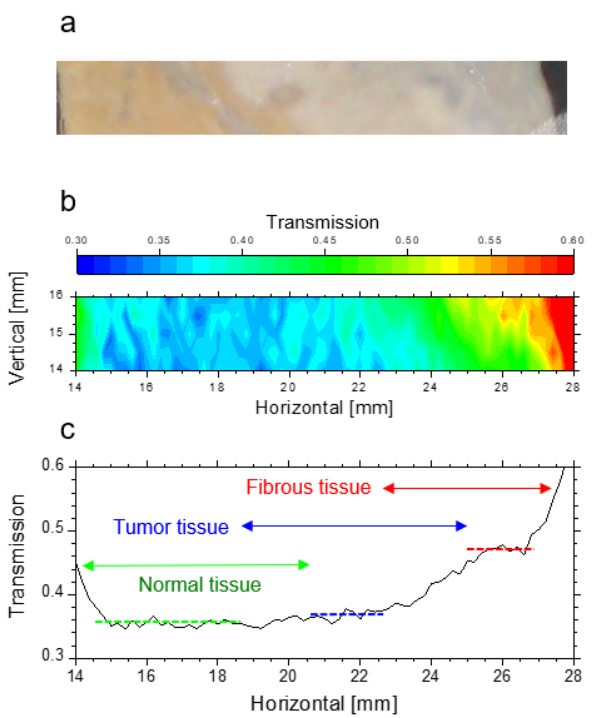
Figure 5. Terahertz (THz) imaging for a highly fibrotic tumor tissue (sample #1): ( a ) visible image, ( b ) THz image, and ( c ) transmissions averaged in the vertical direction. The regions where the normal tissue (green), the tumor tissue (black), and the fibrous tissue (red) are distributed are indicated by double-headed arrows in ( c ). The dotted line represents the average transmittance value for each tissue.